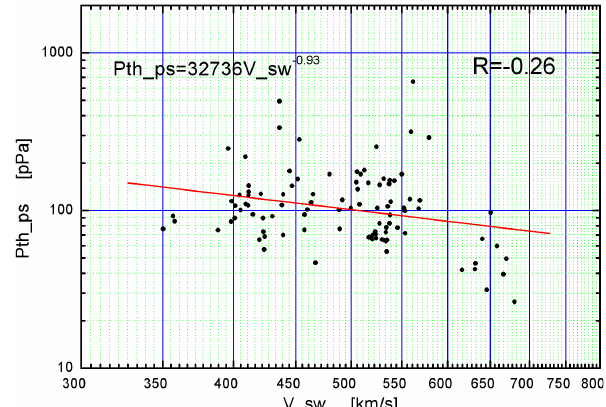
Fig. 7. The relationship between the speed of the solar wind and the ion thermal pressure in the plasma sheet.